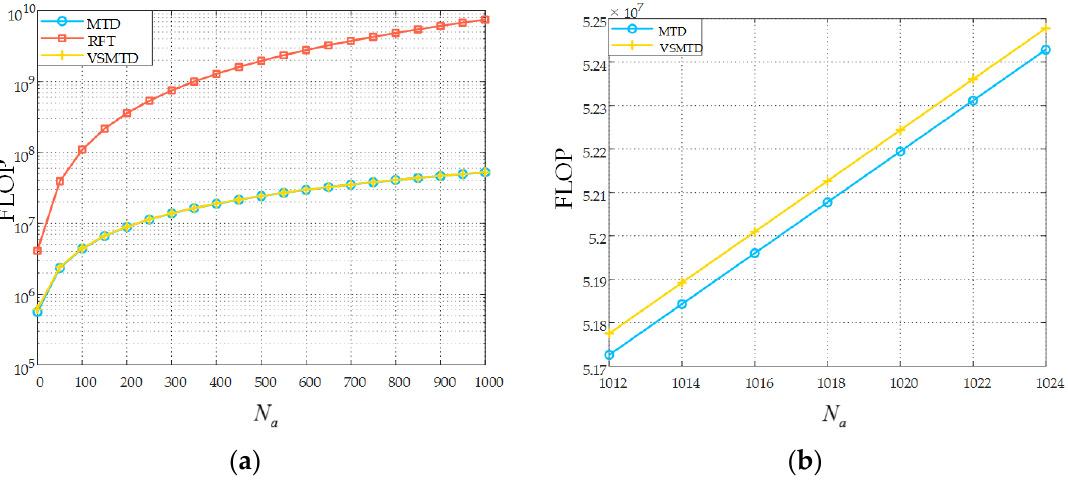
Figure 14. ( a ) Computational amount of all methods; ( b ) Comparison of MTD and VSMTD.